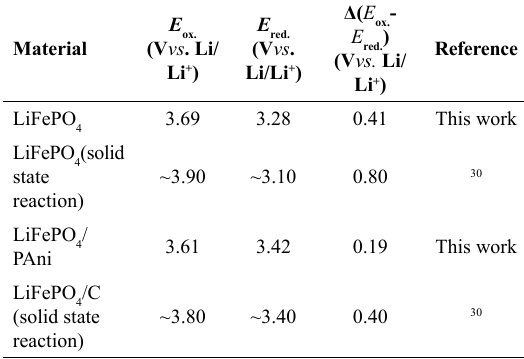
Table 3. Values of oxidation and reducing potential vs. Li/Li + for LiFePO and LiFePO 4 4